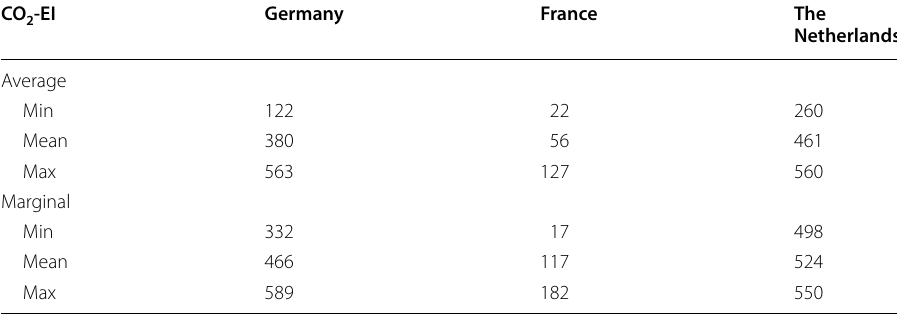
Table 6 CO 2 -emission intensity (CO -EI) of 2018 in Germany, France, and The Netherlands: 2 minimum, mean, and maximum values in kg CO 2 -eq/MWh